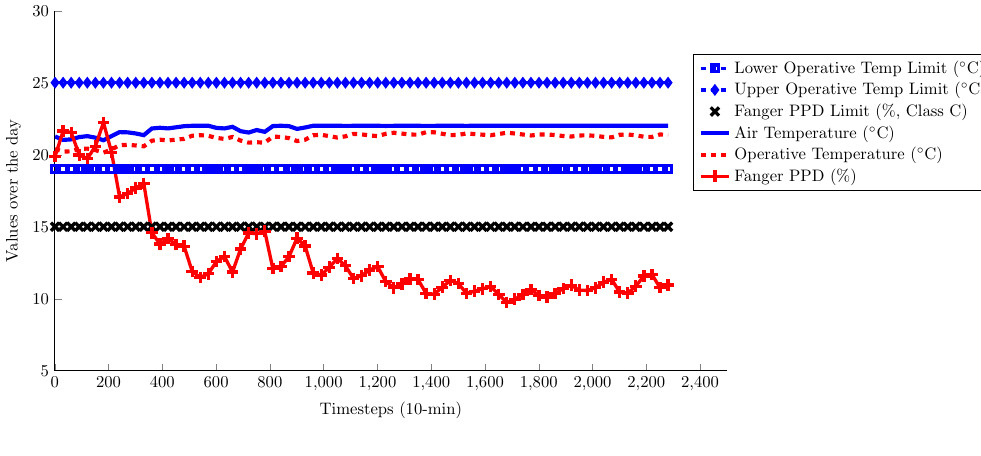
Figure 10. Winter results for Office 08 using the air temperature thermostat set at 22 ◦ C.